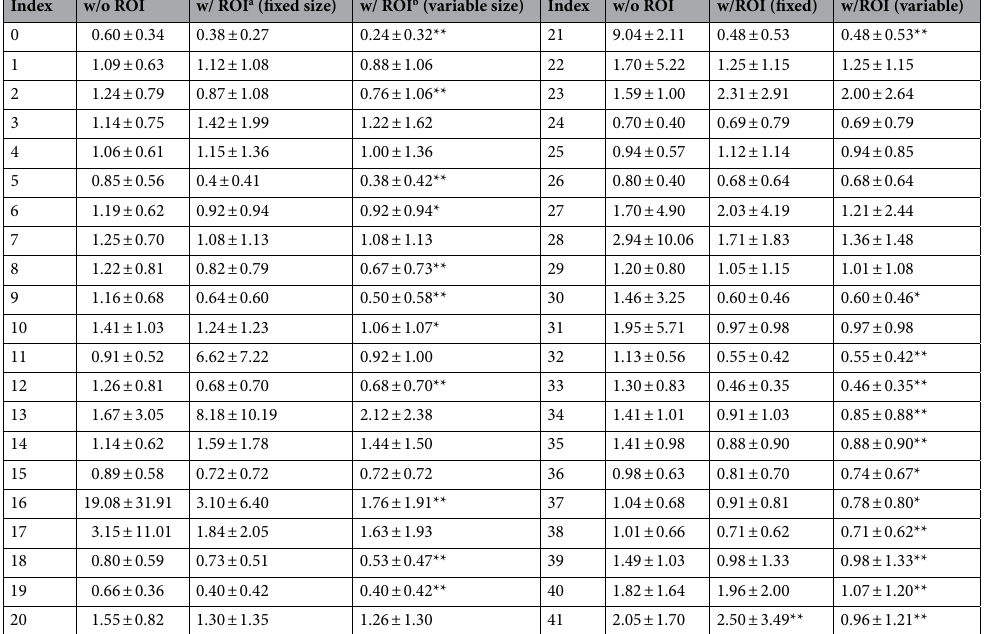
Table 4. Comparisons of distance error (Mean ± STD, unit: mm) of each landmark between prediction without the ROI detection and with the ROI detection of variable size. ROI region of interest, STD standard deviation, w/o ROI Landmark prediction without ROI detection, w/ROI (fixed or variable) landmark prediction with ROI detection of fixed or variable size. * p- value < 0.05; ** p- value < 0.005 using paired t-test. a The accuracy of landmark prediction with ROI detection of fixed size was compared with the accuracies of those without ROI detection. b The accuracy of landmark prediction with ROI detection of variable size was compared with the accuracies of those with fixed